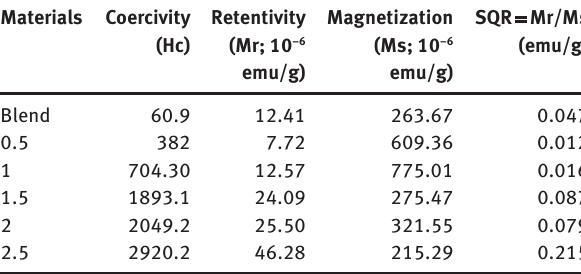
O nanocomposites. 2 3